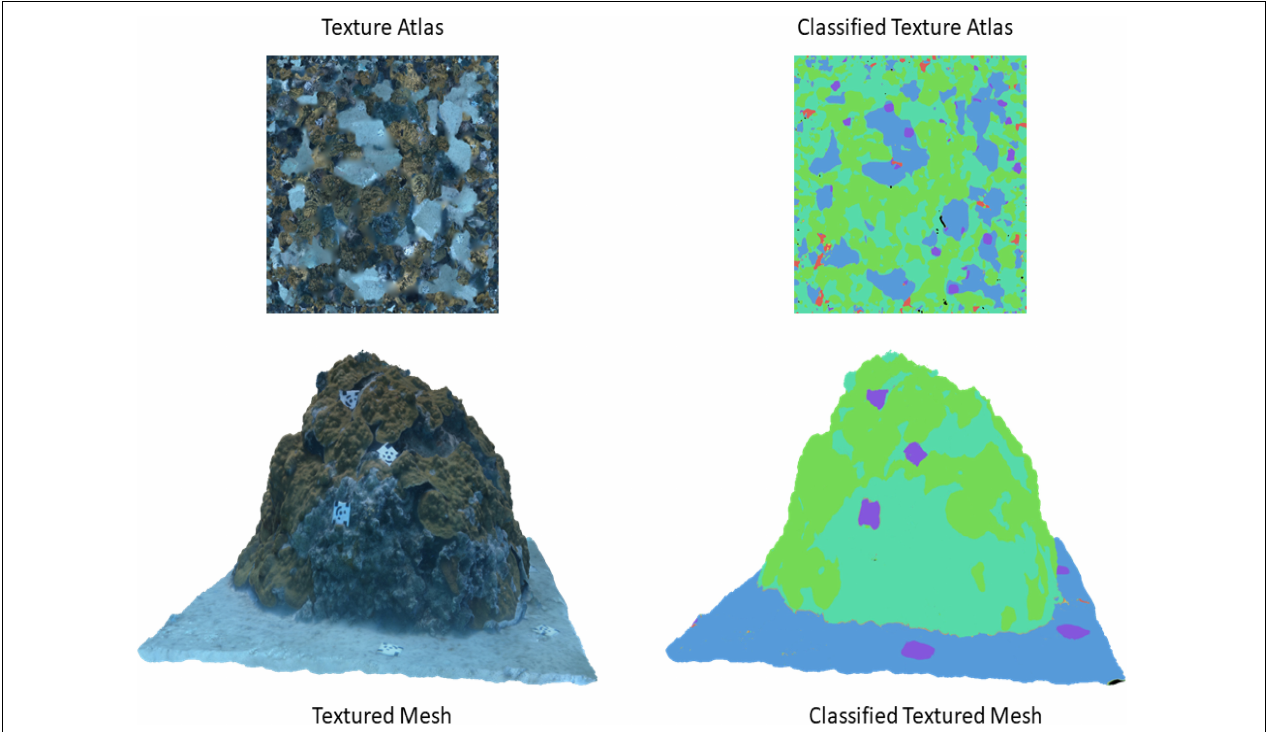
FIGURE 6 | Comparison between the textured mesh and its corresponding atlas (left) against the classified version of the mesh and its corresponding atlas after being corrected using the custom post-processing script